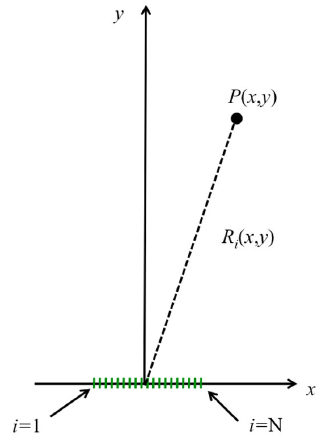
Figure 3. Focusing Figure 3. Focusing geometry.